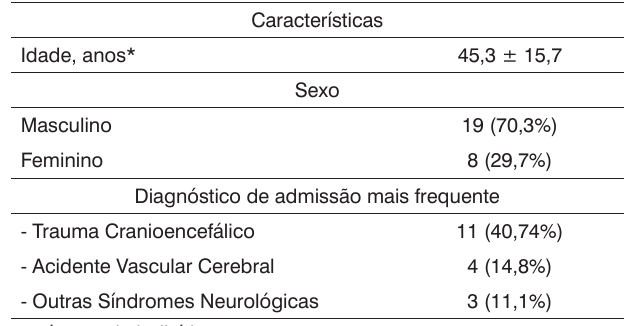
Tabela 1. Características dos pacientes incluídos no estudo (n = 27).